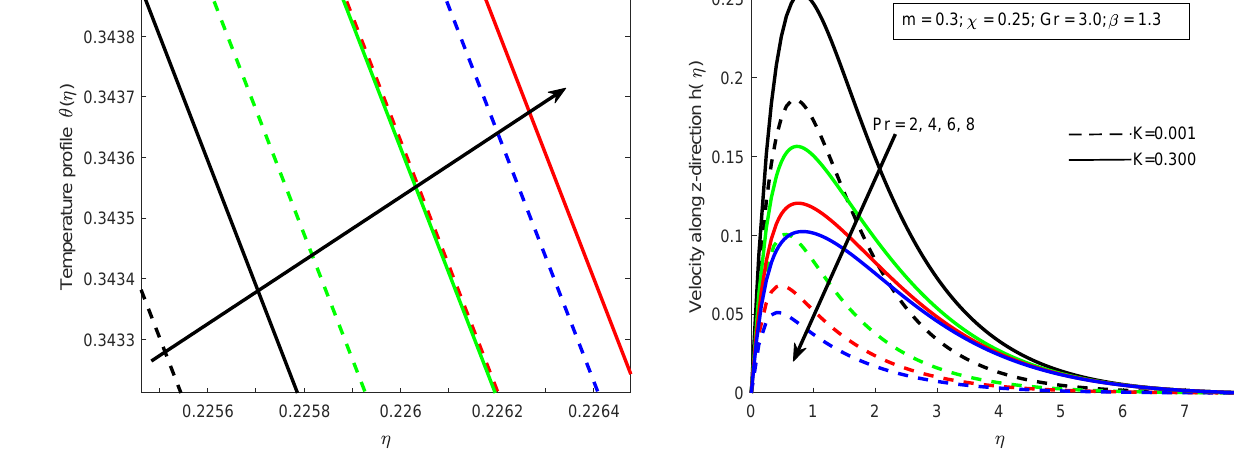
Figure 17: Variation of velocity profile in the z -direction with Prandtl number ature difference between wall temperature and free